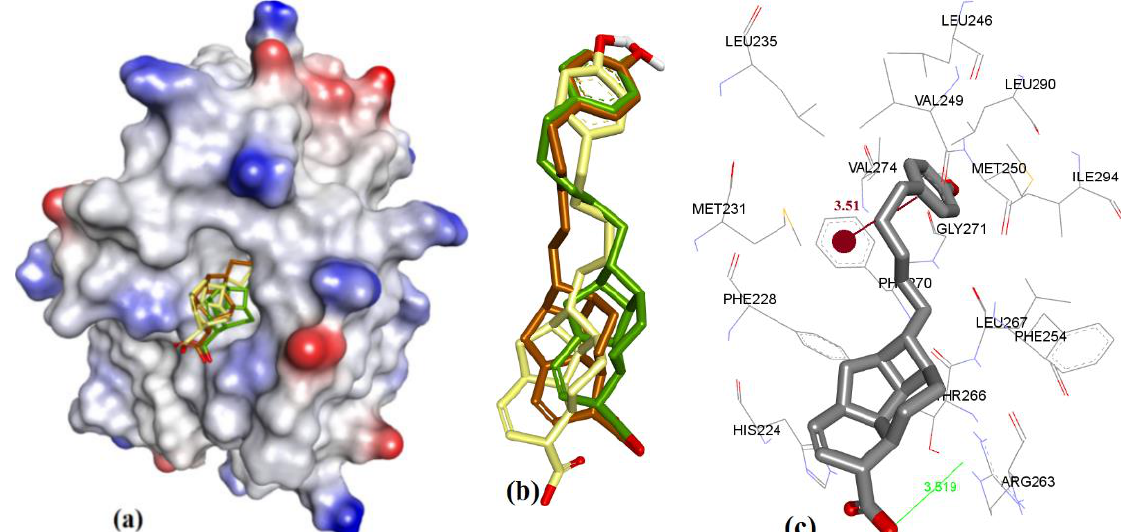
Figure 13. ( a ) The ionized solvent-exposed surface mapping of hMcl-1 along with the docked poses of 4a from MOE (in brown), AutoDock (in green), and VlifeDock (in yellow) show their fitting to the cavity. ( b ) Similar-pose ensemble clustering of all three poses was attained from the three different docking methods. ( c ) Binding mode of 4a .